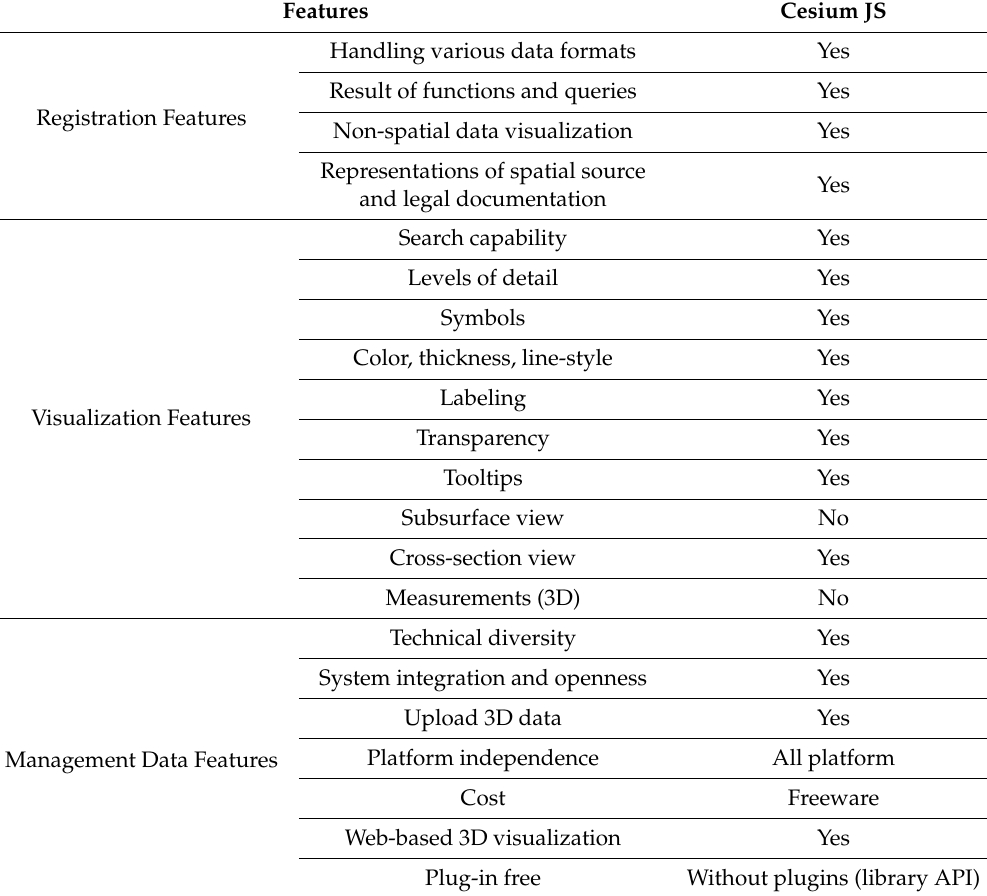
Figure 9. Examples of a 3D property visualization and its corresponding attributes. Table 4. The system capabilities to visualize registered 3D cadastre